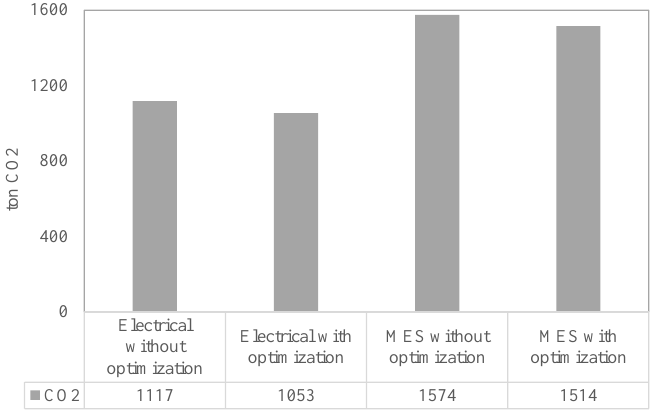
Figure 22. Annual emission of CO 2 .